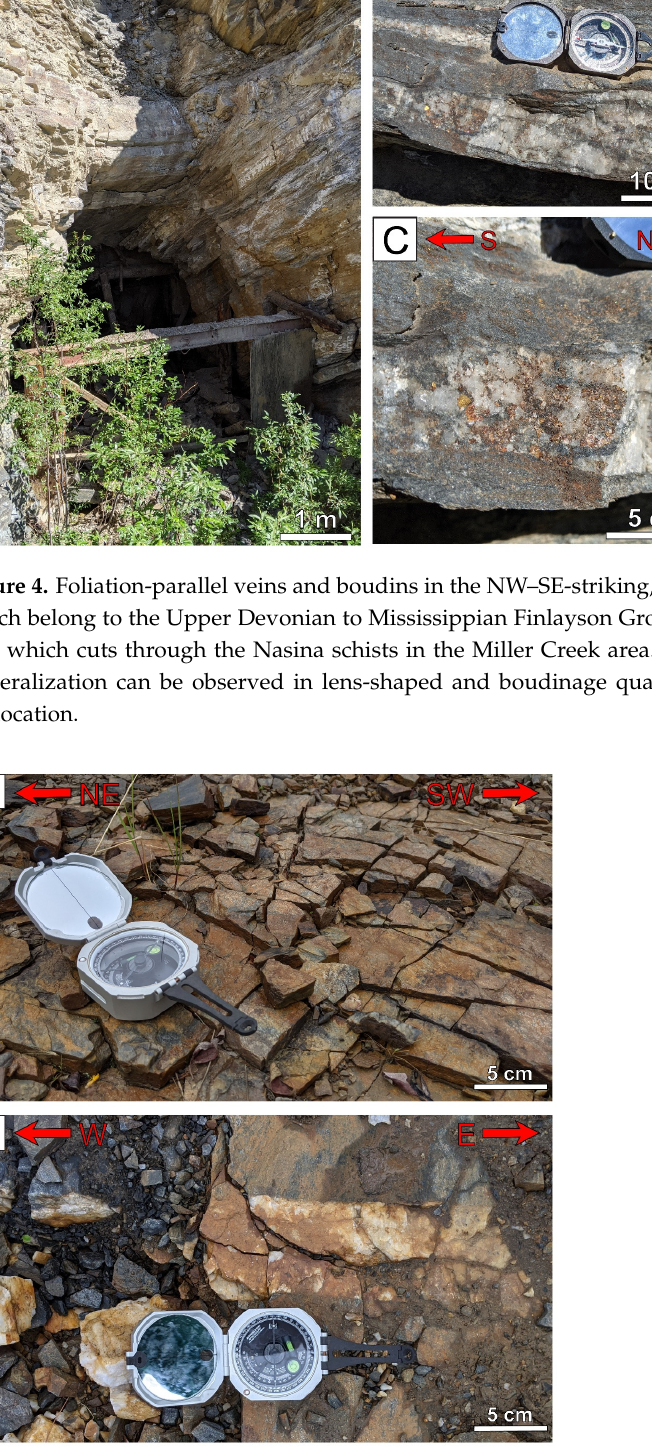
Figure 5. Near-vertical fractures and veins in the Glacier Creek area cutting Nasina Schists, which belong to the Upper Devonian to Mississippian Finlayson Group (DMF3) ( A , B ). Refer to Figure 2 for location.